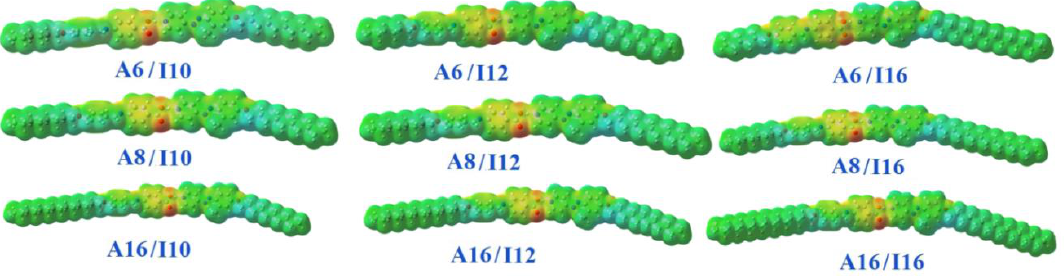
Figure 9. Molecular electrostatic potentials (MEP) for SMHBCs, An / Im